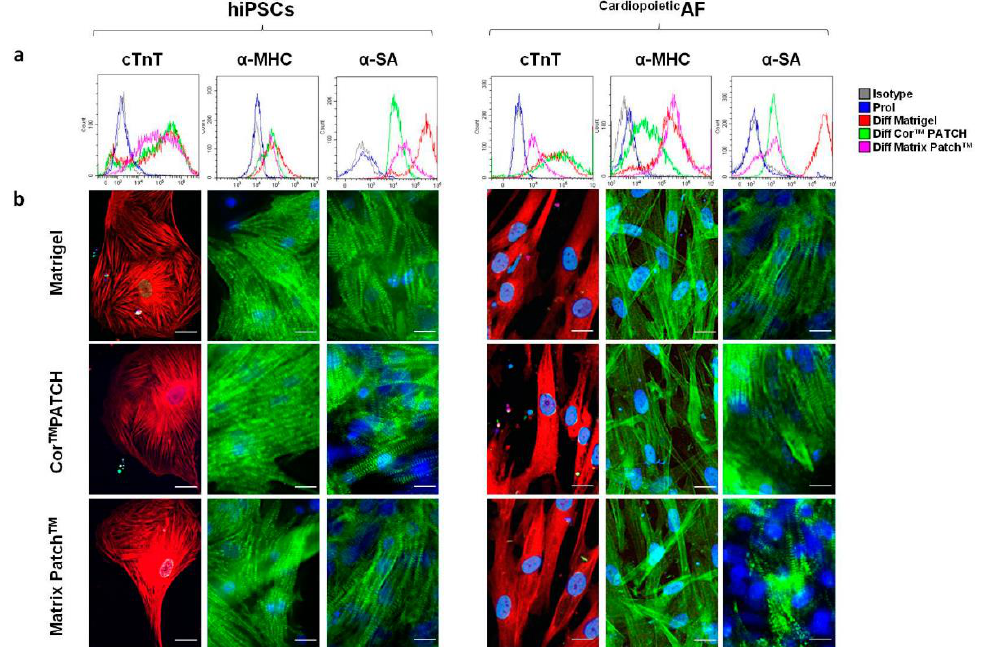
Figure 3. Decellularized extracellular matrices used in cardiac surgery can efficiently support the proliferation and cardiac differentiation of stem cells. Human induced pluripotent stem cells (hiPSCs) and human amniotic fluid cells that express the multipotency markers SSEA4, OCT4, and CD90 ( Cardiopoietic AF) have been differentiated for 15 days on Cor TM PATCH, Matrix Patch TM , or Matrigel ® . The Cor TM PATCH is a decellularized, porcine, intestinal submucosal extracellular matrix used for cardiovascular injury. The Matrix Patch TM is a cell-free, equine-derived, pericardial patch. Matrigel ® is a substrate matrix used for in vitro tests but is not transplantable in humans. ( a ) A flow cytometry analysis of the mature cardiomyocytes hallmark proteins: cardiac troponin T (TnT), α -myosin heavy chain ( α -MHC), and α -sarcomeric actin ( α -SA). ( b ) Immunofluorescent staining for cTnT (red), α -MHC (green), and α -SA (green) in hIPSCs and Cardiopoietic AF cells on Core TM PATCH, Matrix Patch TM , or Matrigel ® , as indicated. The nuclei were counterstained with DAPI (blue). Scale bar: 10 µ m. Reproduced with permission